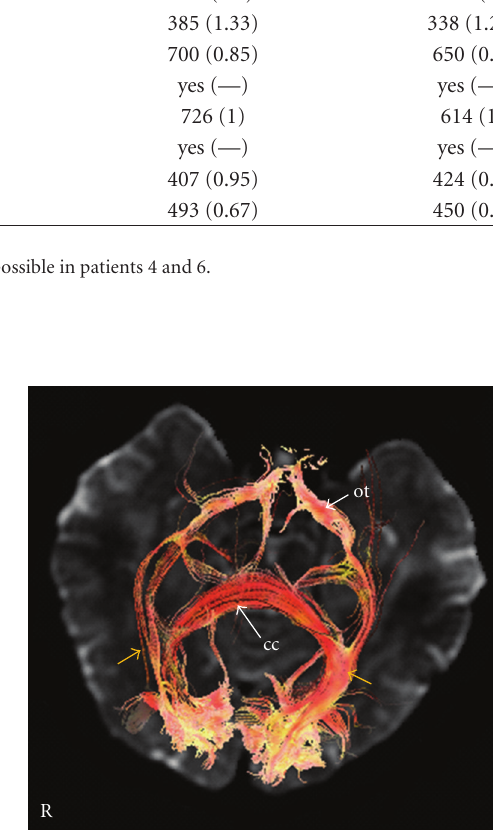
Figure 6: Optic radiations (yellow arrows) reconstructed using DTI fibre tracking in a patient with left optic neuritis. The two fibre bundles arise from the visual cortex and mingle with the inferior longitudinal fasciculus and inferior fronto-occipital fasciculus. Fibres also cross the splenium of the corpus callosum (cc). ot: optic tracts. L and R: left and